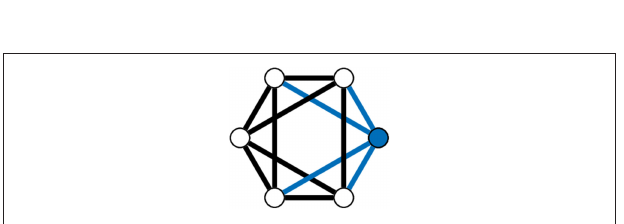
FIGURE 11 | A 4-Regular Ring Lattice on a 6 node graph. The blue edges connected to node 1 show why this graph is 4-regular graph—all nodes have exactly 4 edges connecting them to their 4 closet